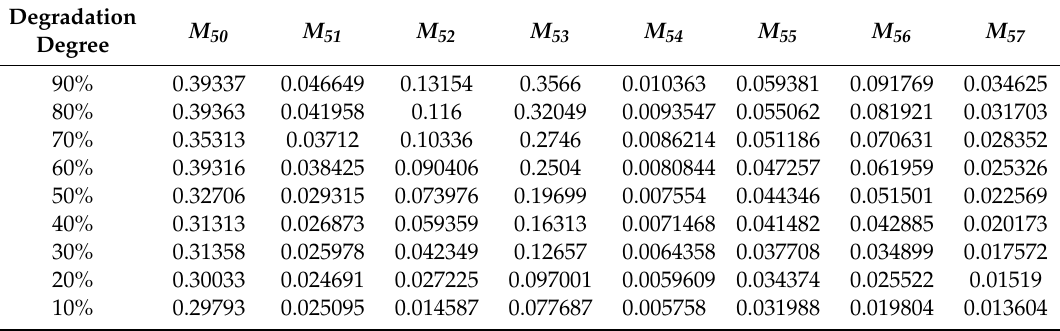
Table 2. Wavelet packet energy moments M ij for each degradation